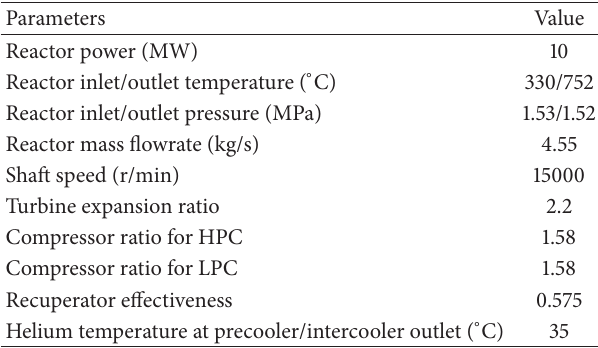
Figure 1: Layout of the system structure of HTR-10GT with candidate bypass valve positions illustrated. Table 1: Specification of HTR-10GT